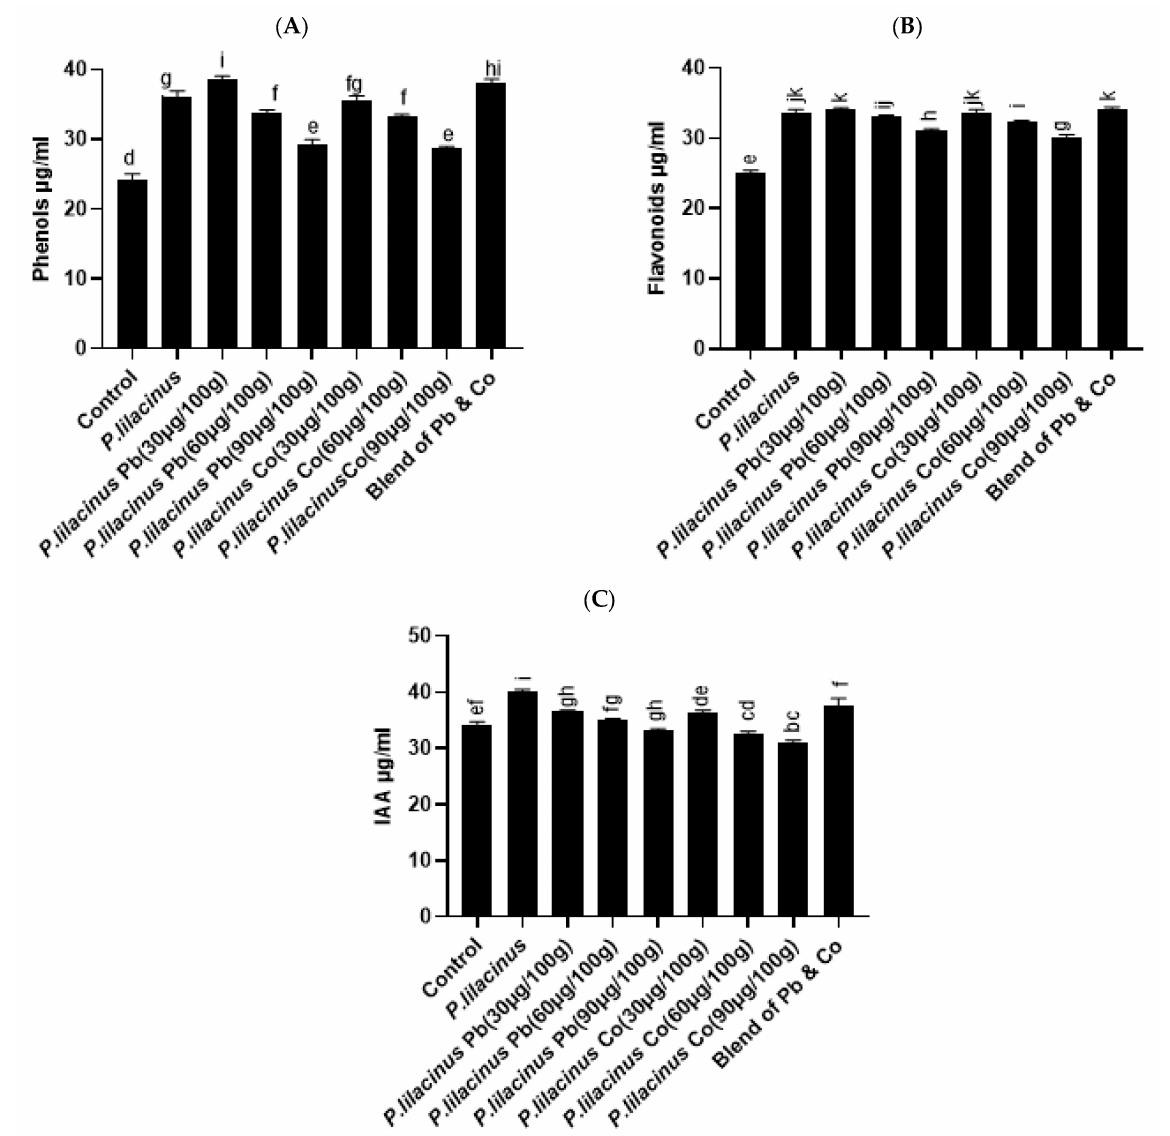
Figure 7. ( A ) Effect of lead and cobalt stresses on phenols of S. lycopersicum inoculated with P. lilacinus and without P. lilacinus . Bars represents mean of triplicates with ± SE. Alphabets above the bars are different significantly from one another at p ≤ 0.05. ( B ) Effect of lead and cobalt stresses on flavonoids of S. lycopersicum inoculated with P. lilacinus and without P. lilacinus . Bars represents mean of triplicates with ± SE. Alphabets above the bars are significantly different from one another at p ≤ 0.05. ( C ) Effect of lead and cobalt stresses on IAA of S. lycopersicum inoculated with P. lilacinus and without P. lilacinus . Bars represent mean of triplicates with ± SE. Alphabets above the bars are significantly different from one another at p ≤